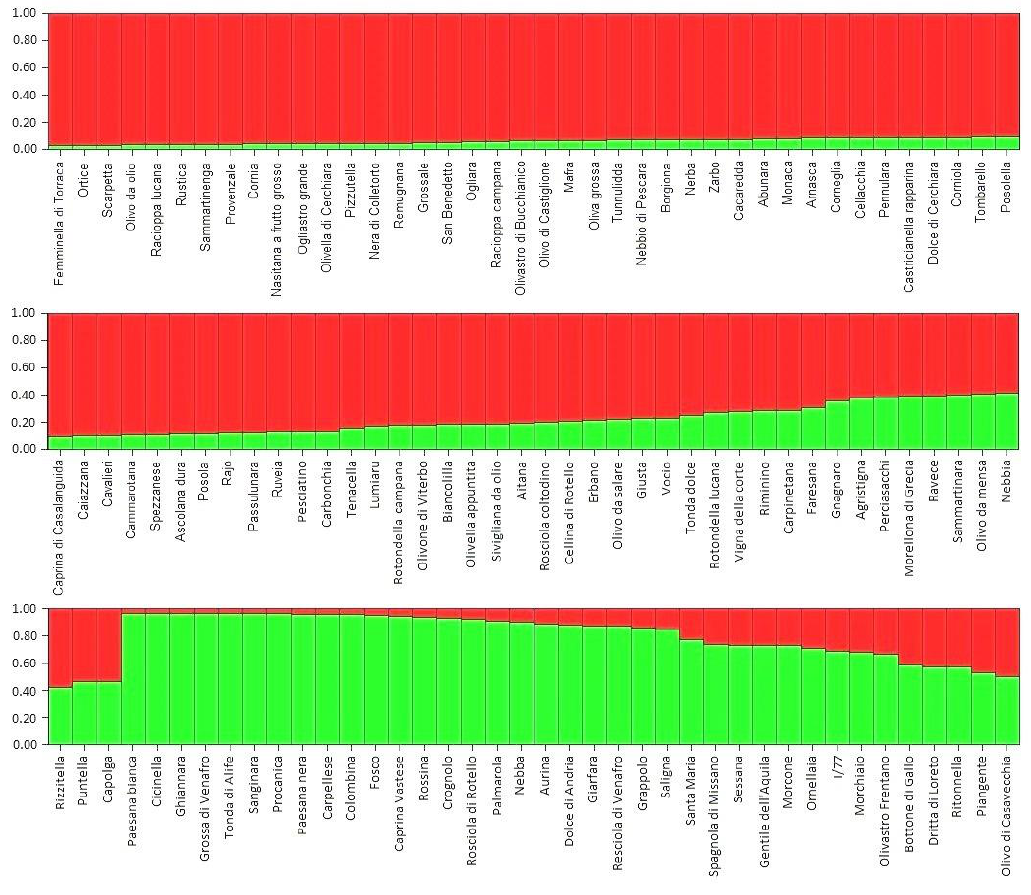
Figure 6. Population structure analysis showing the two differentiated groups (Red and Green) and the list of red, green, and admixed cultivars.